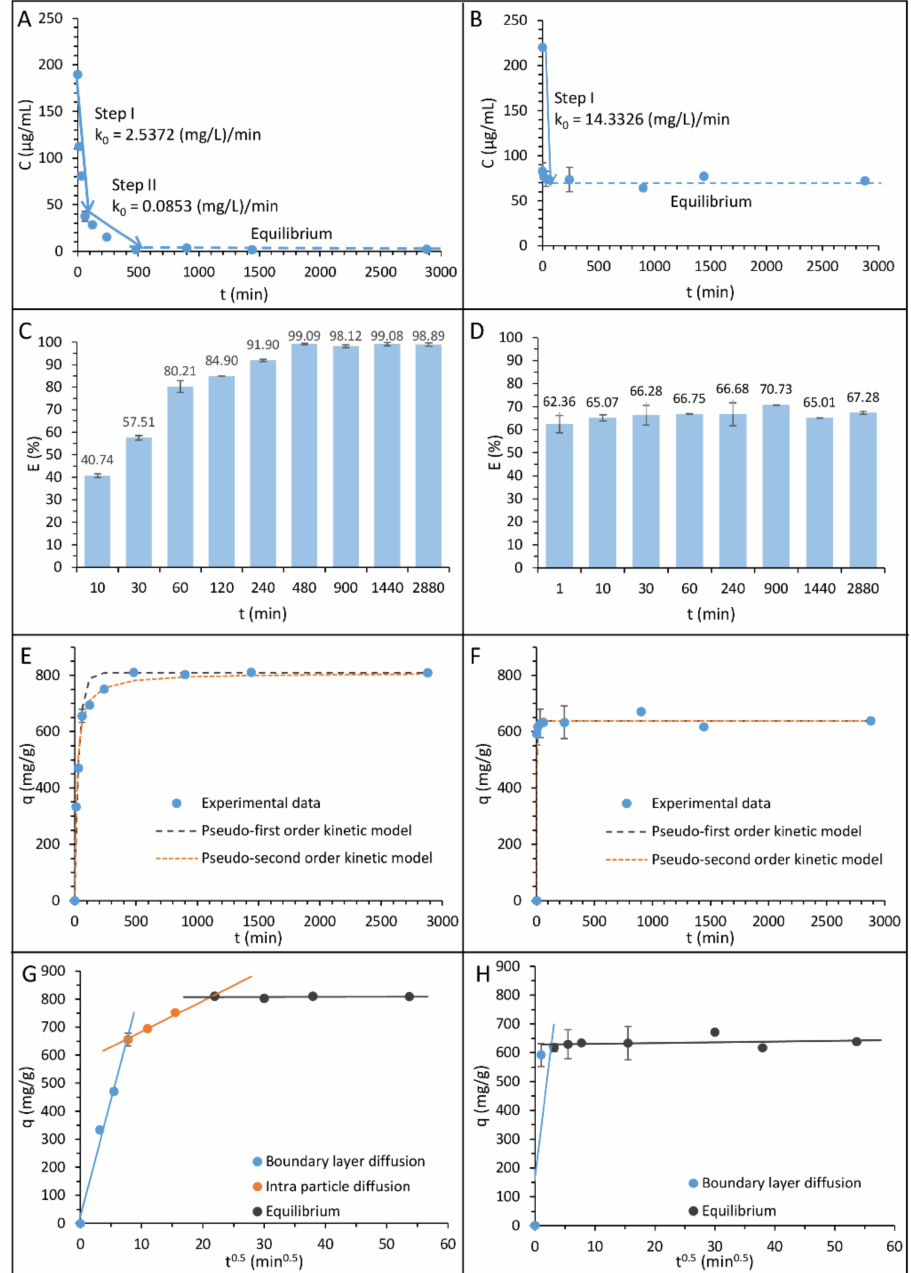
Figure 1. The kinetic steps and rate constant values determined by the zero order kinetic model for ampicillin ( A ) and tetracycline ( B ); the effectiveness of the sorption process for ampicillin ( C ) and tetracycline ( D ); experimental data and the matching of pseudo-first and -second order kinetic models of the ampicillin ( E ) and tetracycline ( F ) sorption by zinc oxide nanoparticles; the Weber–Morris intra- particle diffusion model of ampicillin ( G ) and tetracycline ( H ) sorption by zinc oxide